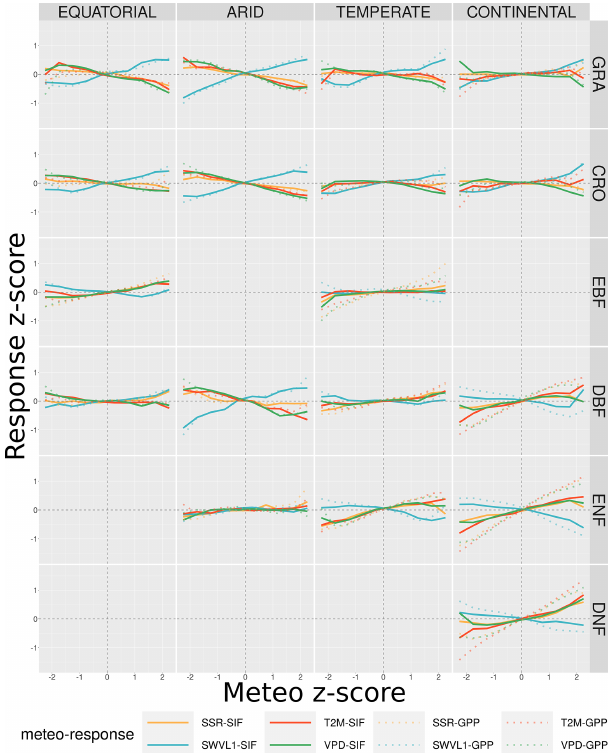
Figure 10. The average fluctuation in the remotely sensed down- scaled SIF and FLUXCOM GPP as a function of the fluctua- tion in several meteorological variables. The fluctuations are de- fined in terms of the z score of each variable, calculated for 10 different bins between − 2.5 and 2.5, and the corresponding me- dian SIF DS / GPP FX z score, relative to the long-term (2007–2014) monthly mean for each pixel (each pixel may contribute multiple months within the growing season). The meteorological variables considered are from the Copernicus Climate Service (C3S) Climate Data Store (CDS) and are surface net solar radiation (ssr), air tem- perature (t2m), vapour pressure deficit (VPD) and soil moisture (swvl1). The data are broken down into separate Köppen–Geiger climate zones and land cover